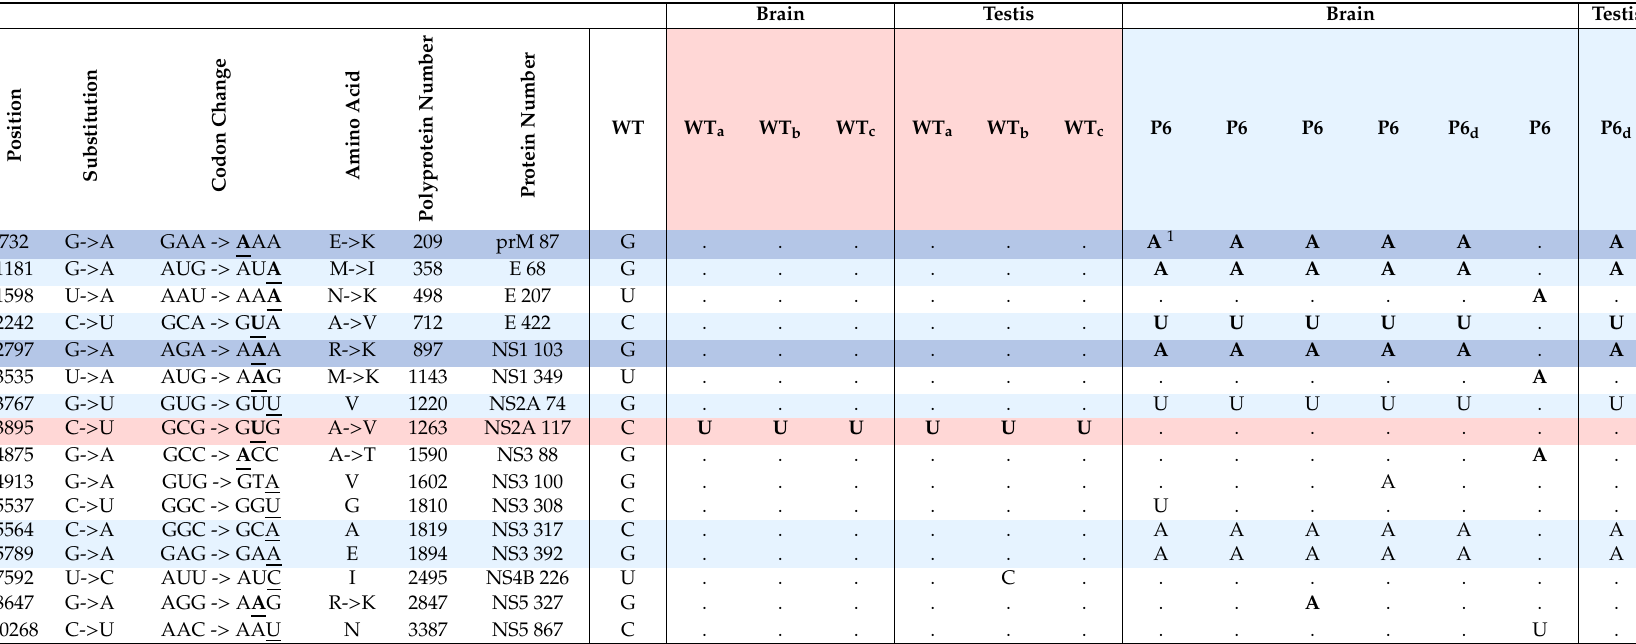
Table 2. Sequences of animal-derived viruses following infection with WT ZIKV or HeLa-P6 stocks. Brain